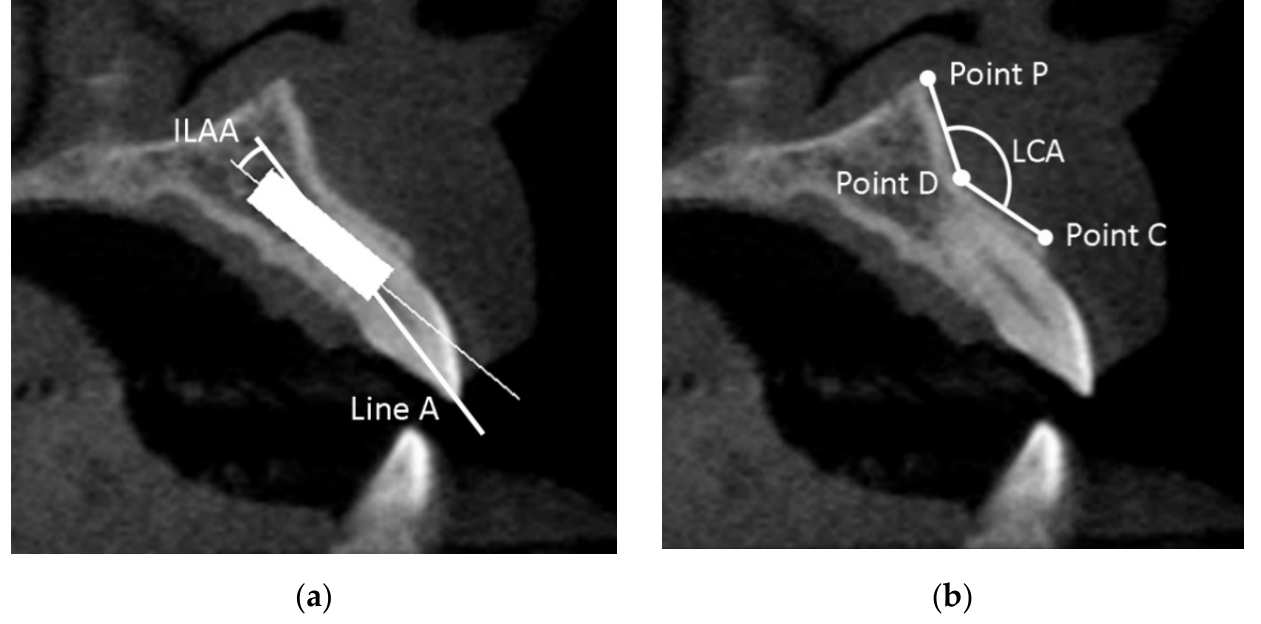
Figure 2. ( a ) The implant-line A angle (ILAA); ( b ) the labial concavity angle (LCA). 2.6.5. Labial Concavity Angle (LCA) The LCA was defined as the angle between the line D–C and the line D–P (Figure 2b). Point C was defined as the most coronally external point of the labial plate, point D